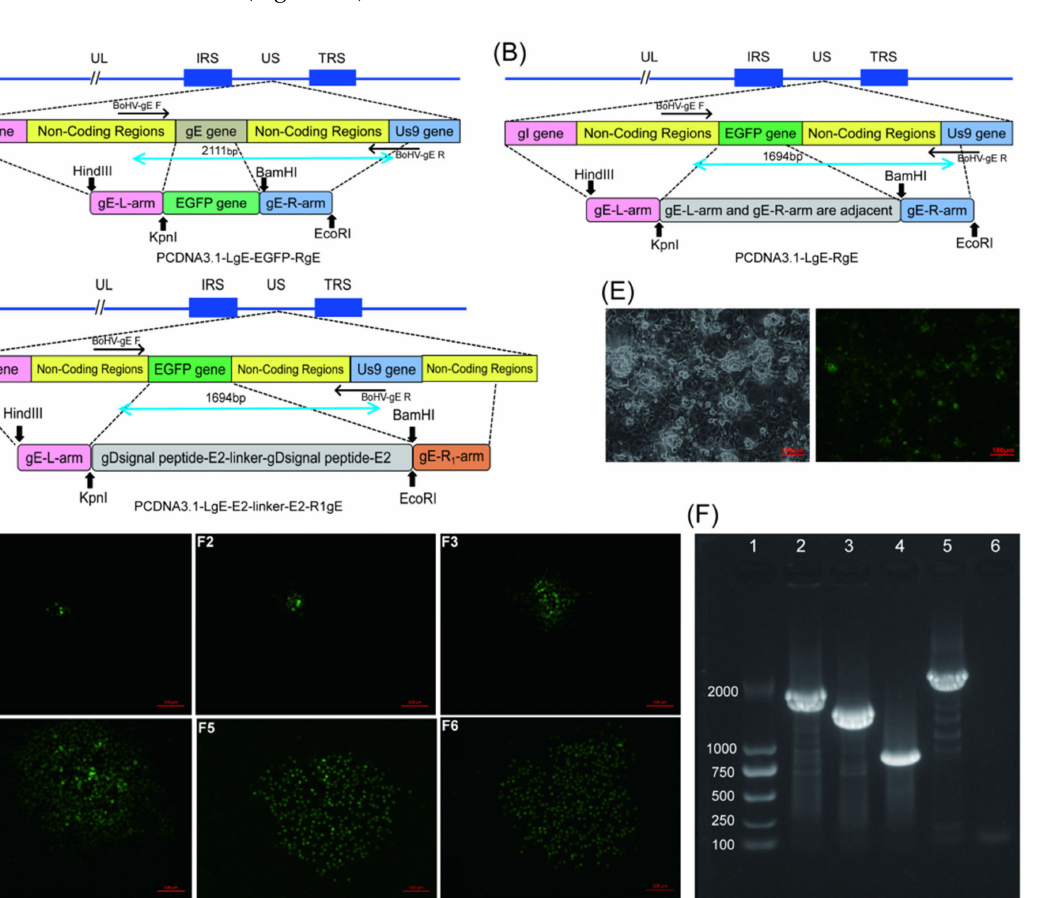
Figure 1. Construction of BoHV − 1 donor plasmids and screening of recombinant viruses. ( A ) The sequence information of the pCDNA 3.1-LgE-EGFP-RgE donor plasmid and the recombinant site inserted into the BoHV − 1 genome while using CRISPR/Cas9 system to edit BoHV − 1; ( B ) pCDNA 3.1-LgE-E2-Linker-E2-R1gE; ( C ) pCDNA3.1-LgE-RgE; ( D ) BoHV − 1 gE/EGFP + was